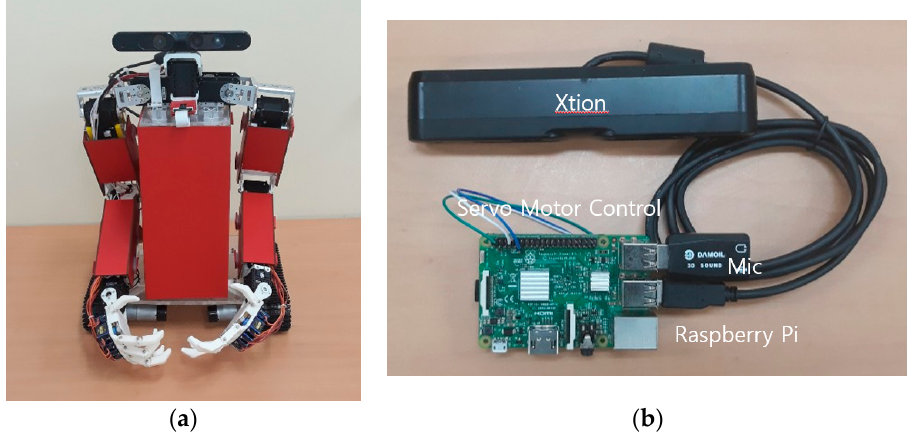
Figure 7. A test bed of FaaS-FR using Raspberry Pi. ( a ) The service robot, ( b ) a Raspberry Pi and perception and behavior